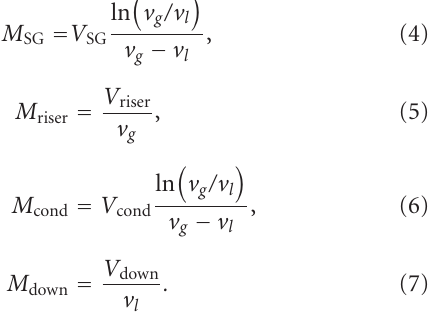
Figure 7: Filling ratio boundaries as a function of pressure and downcomer subcooling for IES loop.